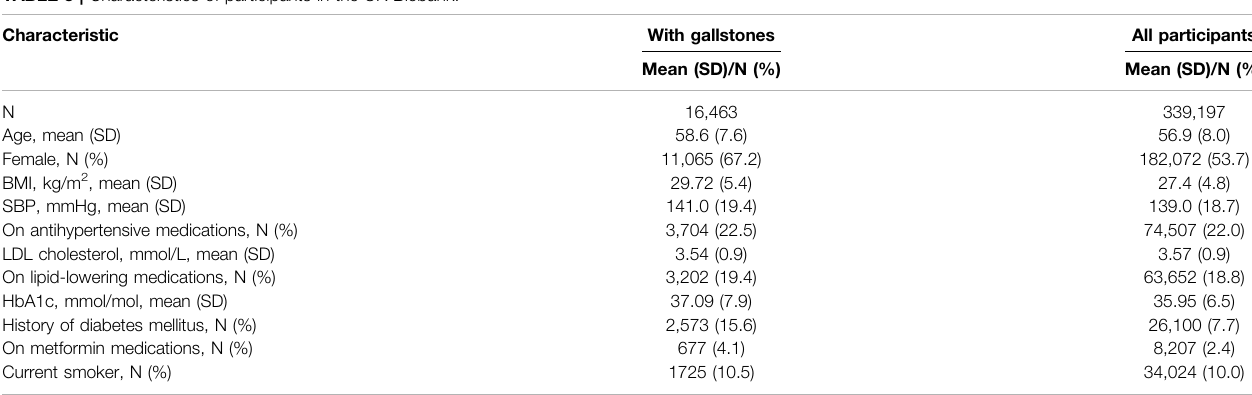
TABLE 3 | Characteristics of participants in the UK Biobank.